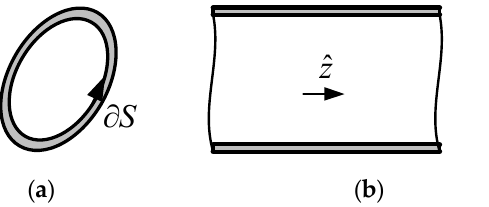
Figure 1. A uniform WLTL: ( a ) cross-section view and ( b ) longitudinal view. For convenience, the transverse modal fields of e TE ascending order according to their cutoff frequencies, and the superscripts “TE” and “TM” are omitted. Note that the transverse modal fields are orthonormal,